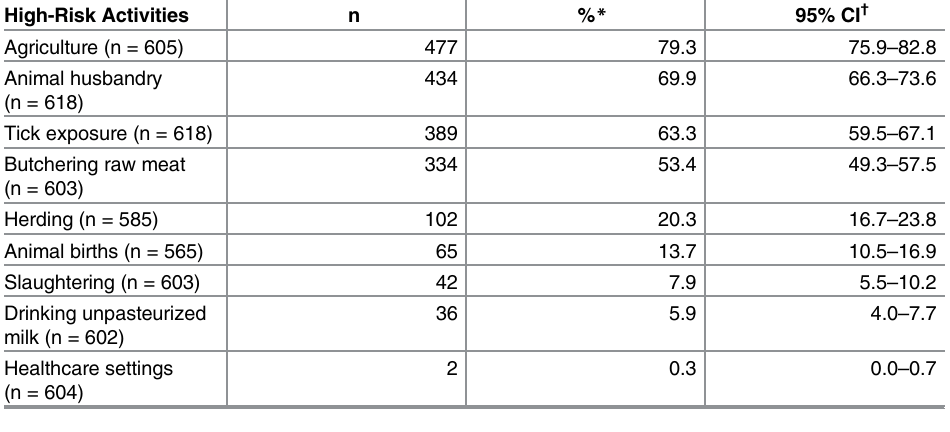
Table 4. Crimean-Congo hemorrhagic fever (CCHF) high-risk activities among survey participants during an investigation of the 12 rural villages reporting at least one 2014 CCHF case from January to September 2014 in